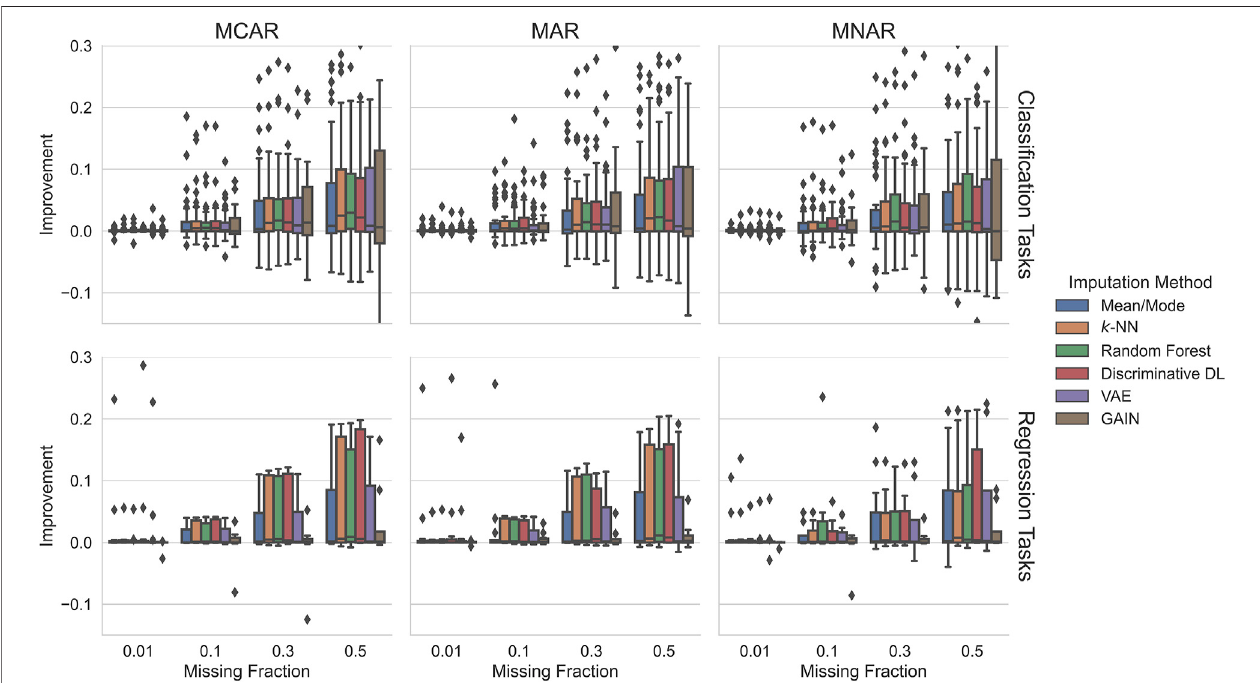
FIGURE 3 | Does imputation on incomplete test data improve predictive performance of a downstream ML model? We plot the improvement of the downstream ML model after imputation with imputation models trained on fully observed data. The downstream performance is compared to the performance obtained on incomplete test data, normalized by the ML model performance on fully observed test data. Overall, the classical ML methods and discriminative DL perform best achieving relative improvements of up to 10% and more relative to fully observed test data.